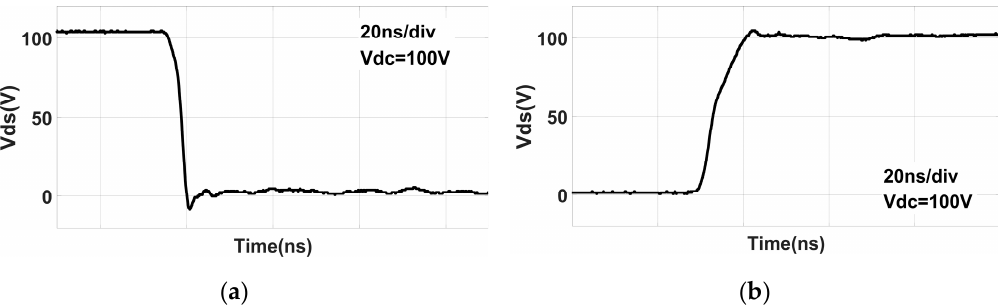
Figure 5. Drain-source voltage waveforms of the integrated module under 𝑉 (cid:3031)(cid:3030) = 100 V : ( a ) turn-on period; ( b ) turn-off period.